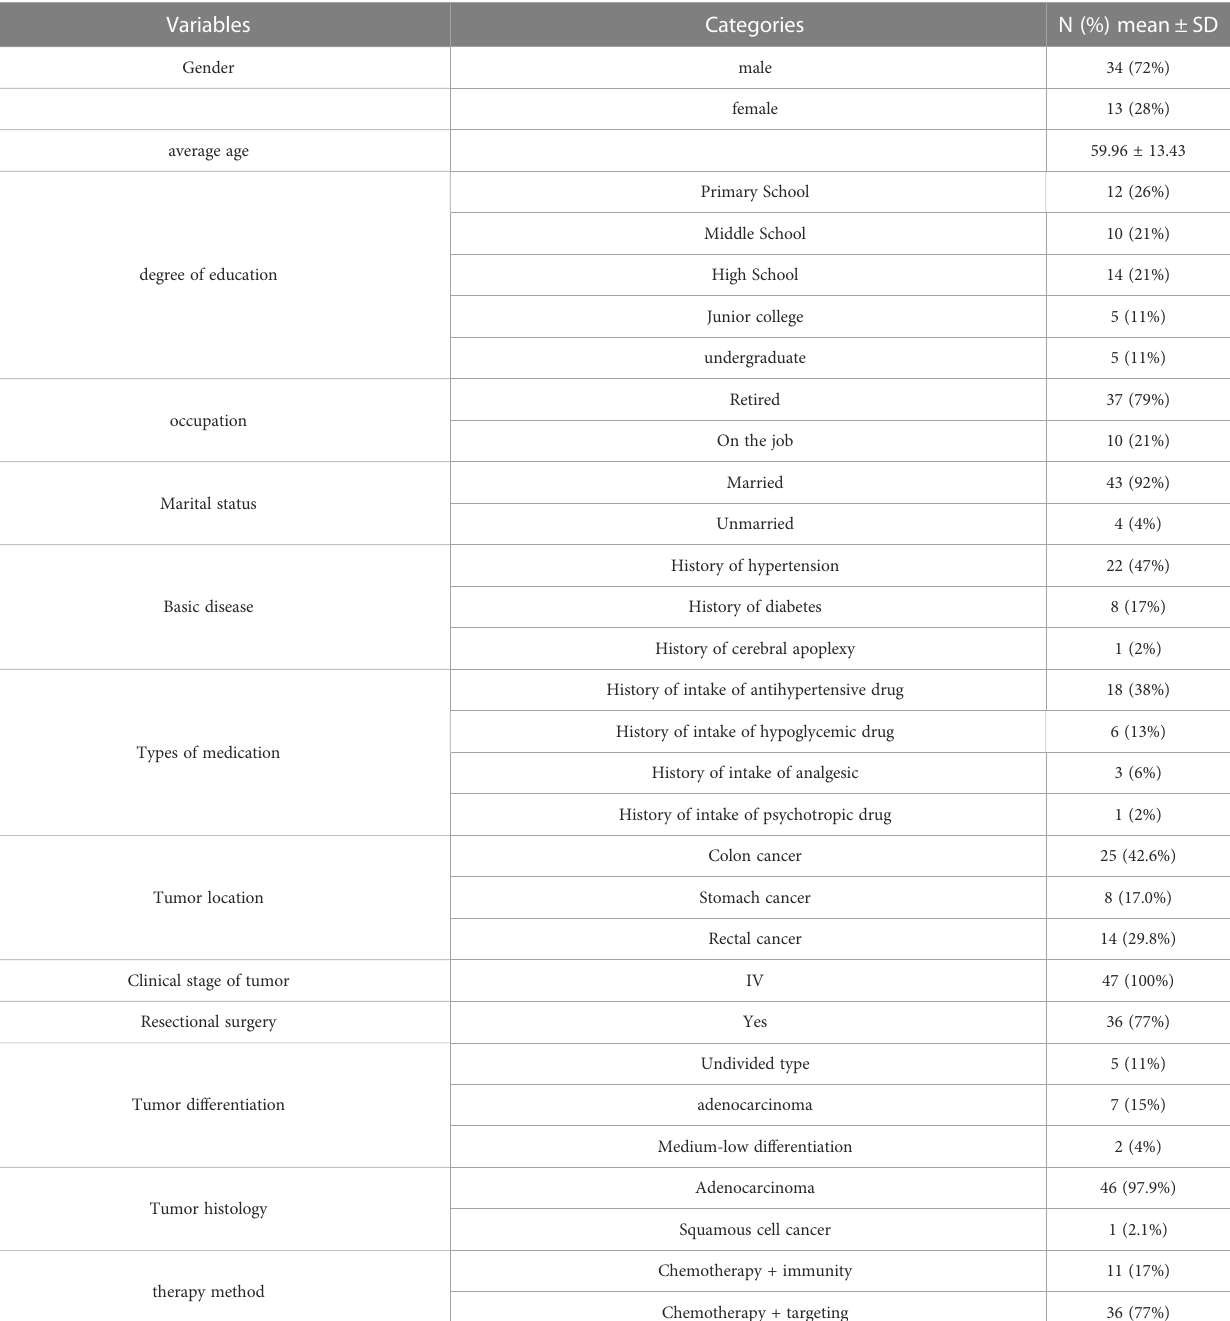
TABLE 1 Patient characteristics (n =